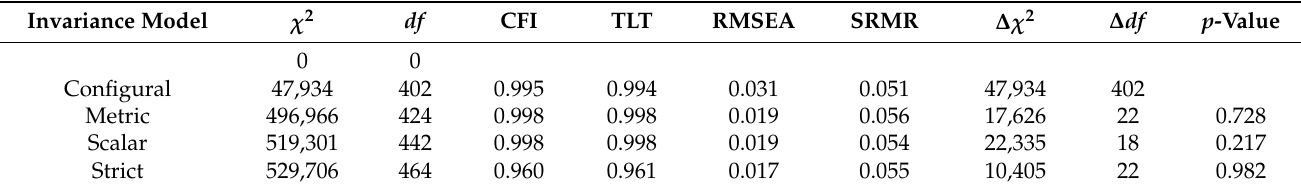
Table 5. Measurement Invariance for